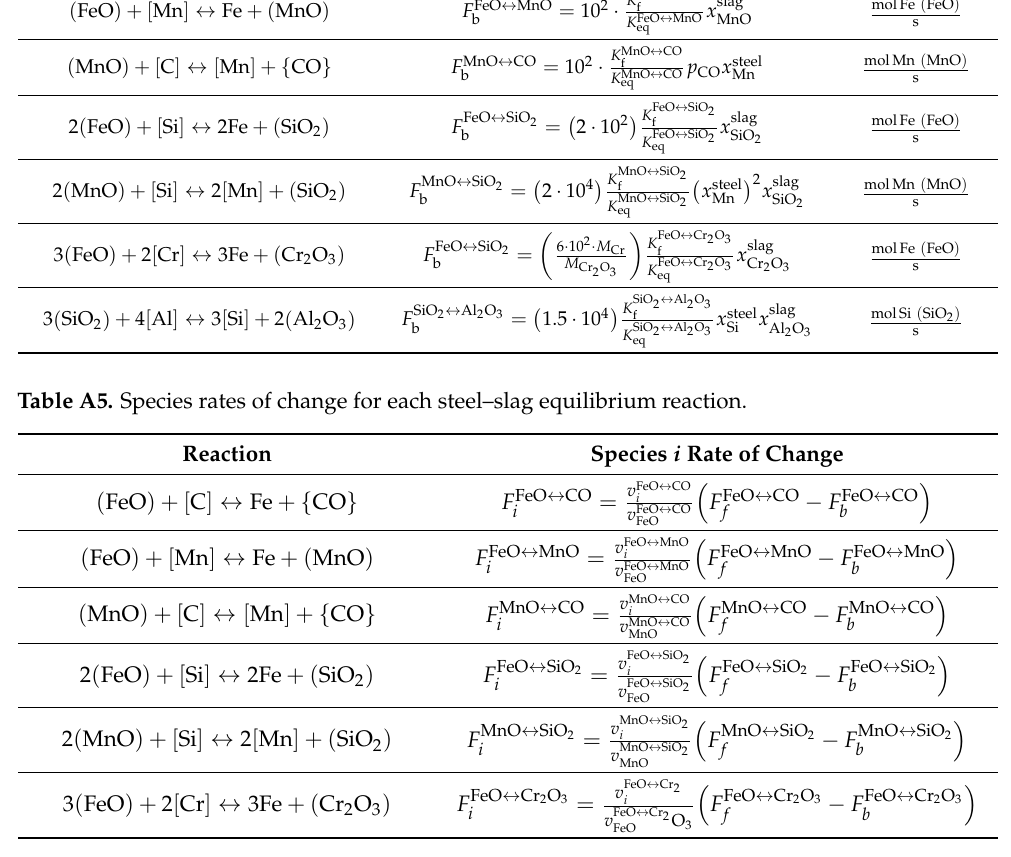
(cid:16) (cid:17) mol can be combined with the molar s